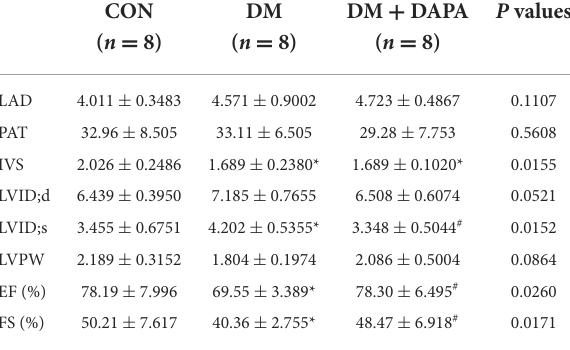
TABLE 1 Echocardiographic